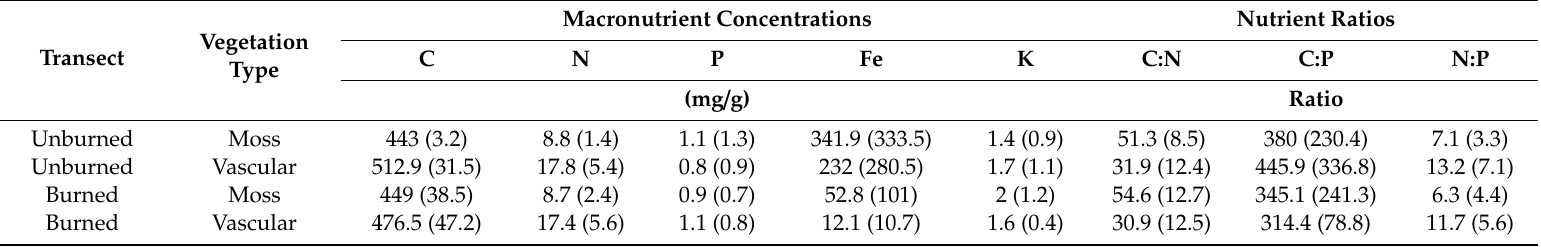
Table 2. Macronutrient concentrations and nutrient ratios are shown for both moss and vascular vegetation from peak season, comparing the Unburned and Burned areas and the microtopographical di ff erence observed. Standard deviations of samples are provided in